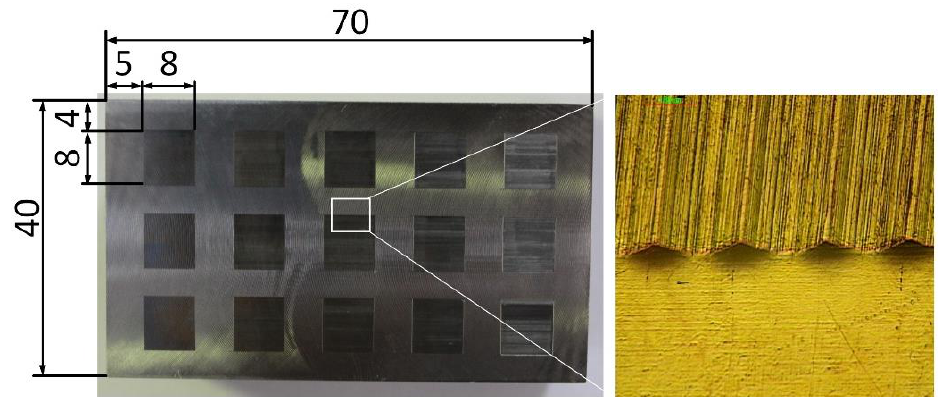
Figure 11. The simulated milled  burnished area ( a ) 3D view, ( b ) 2D profile (Polmax material).